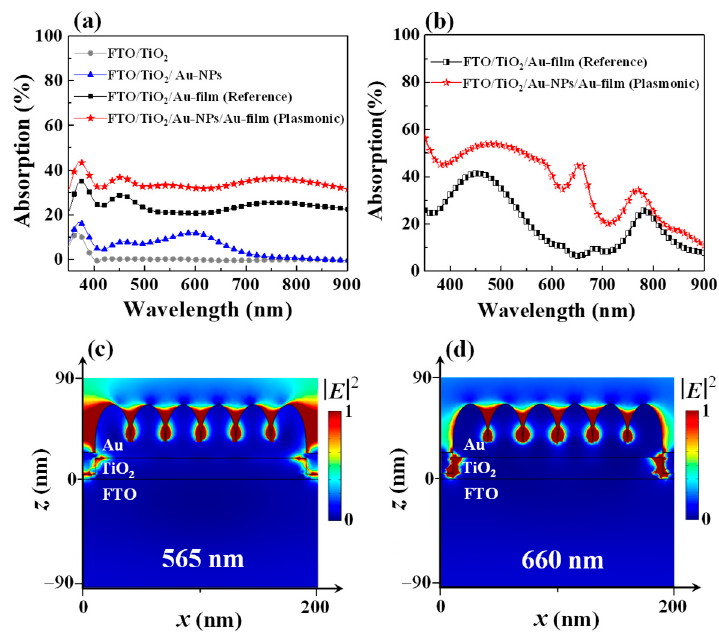
Figure 2. ( a ) Absorption spectra of the hybrid plasmonic and reference HEPDs with the configurations of FTO/TiO 2 /Au NP/Au film and FTO/TiO 2 /Au film, respectively. For comparison, the absorption spectra of the multilayer structures with the configurations of FTO/TiO 2 and FTO/TiO 2 /Au NPs are also displayed. ( b ) Simulated absorption spectra of the hybrid plasmonic and reference HEPDs. Simulated maps of electric filed amplitude | E | 2 of the hybrid plasmonic at the wavelengths of 565 nm ( c ) and 660 nm ( d ).